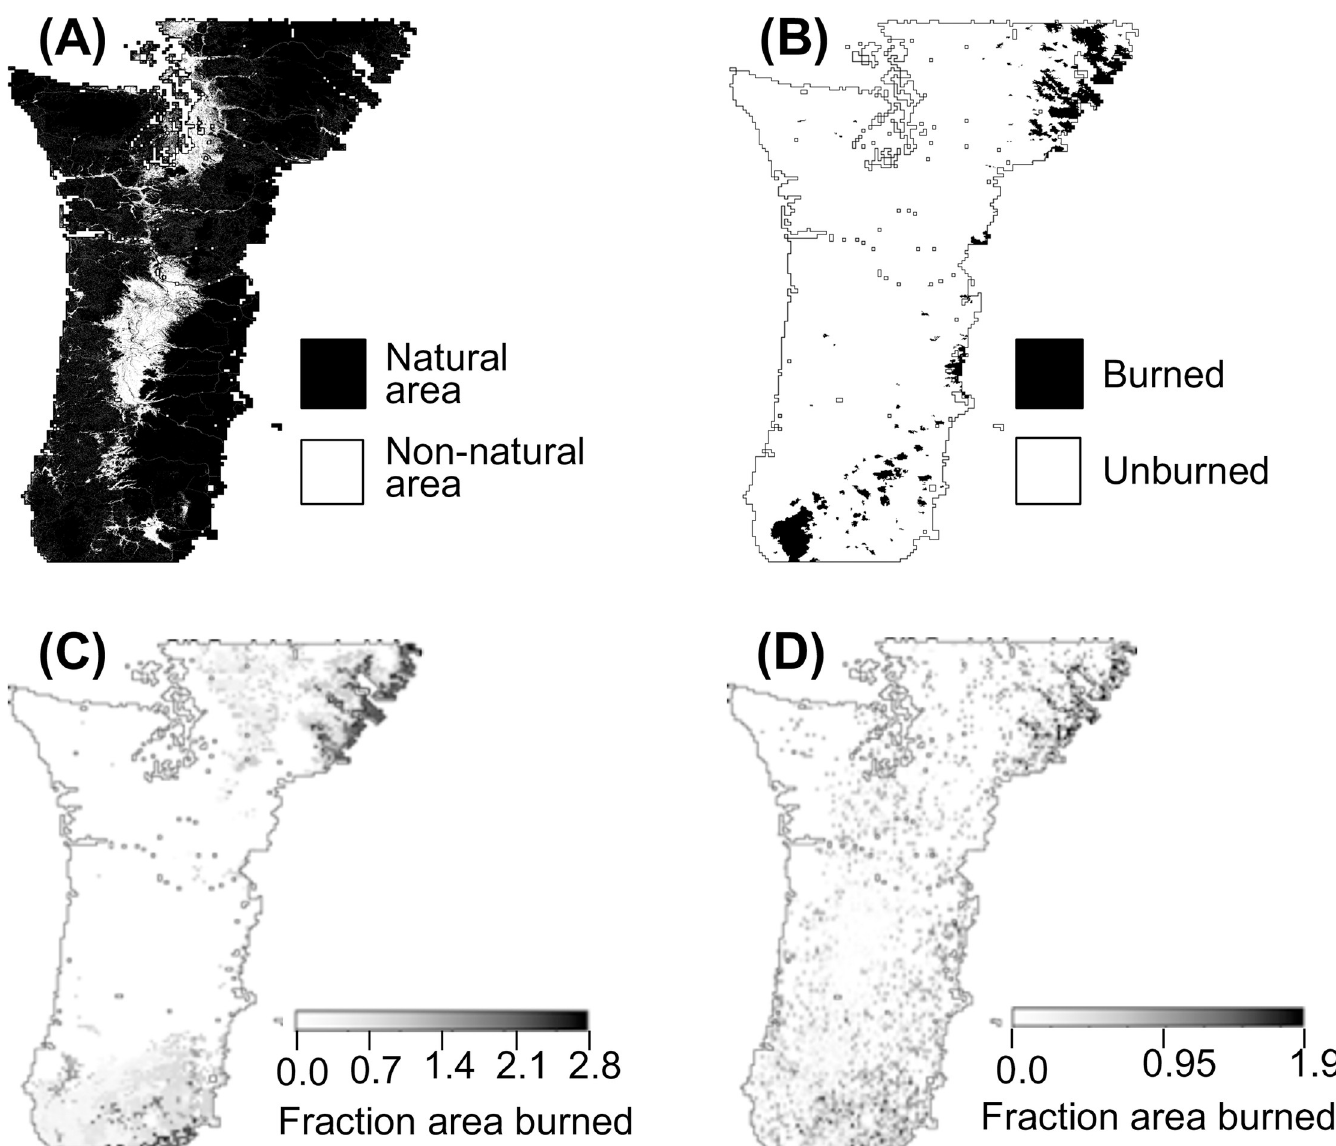
Fig 4. Measures of fire on the landscape. (A) Natural and human-affected areas as determined by reclassifying LandFire vegetation classes; (B) MTBS fire perimeters for 1985–2015; (C) Total NHA (non-human affected) area burned over 1985–2015 (sum of FAB weighted by grid cells’ NHA fraction over 1985–2015) for FF-WCE (full fire, with CO 2 fertilization effect); and (D) Total NHA area burned over 1985–2015 for SF-WCE (no fire suppression, with CO 2 fertilization effect).